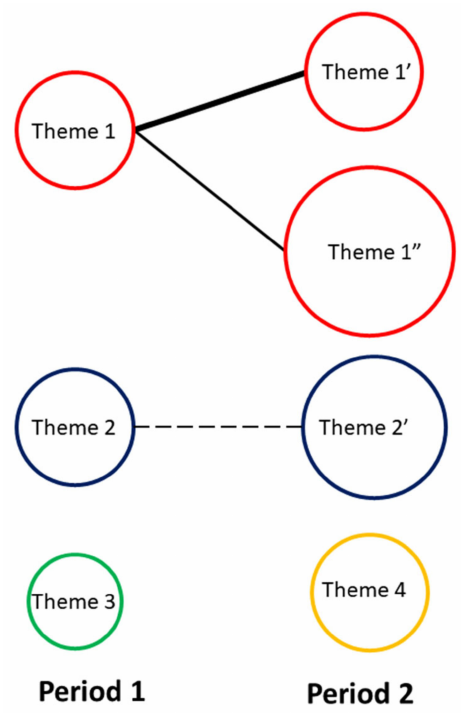
Figure 3. Evolution